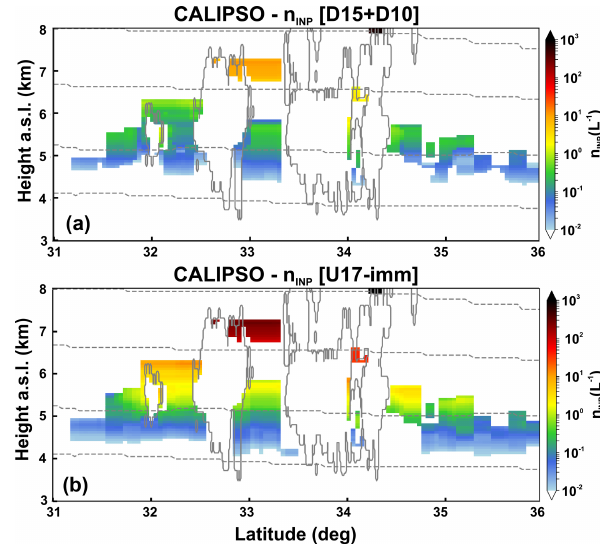
Figure 13. Spatial distribution of the INP concentrations during the event of 21 April 2016 at 11:01UTC, as derived with the D15 + D10 (a) and U17-imm (b) parameterizations. The location of the clouds observed is depicted with gray contours. The dotted lines correspond to T = 0 , − 10 , − 20 and − 30 ◦ C, based on the MERRA- 2